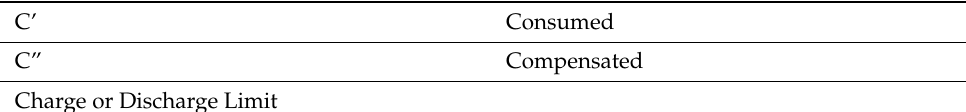
Figure 9. Close-up battery SoC left (Li-ion) and right (LA), respectively. Table 3. Glossary.